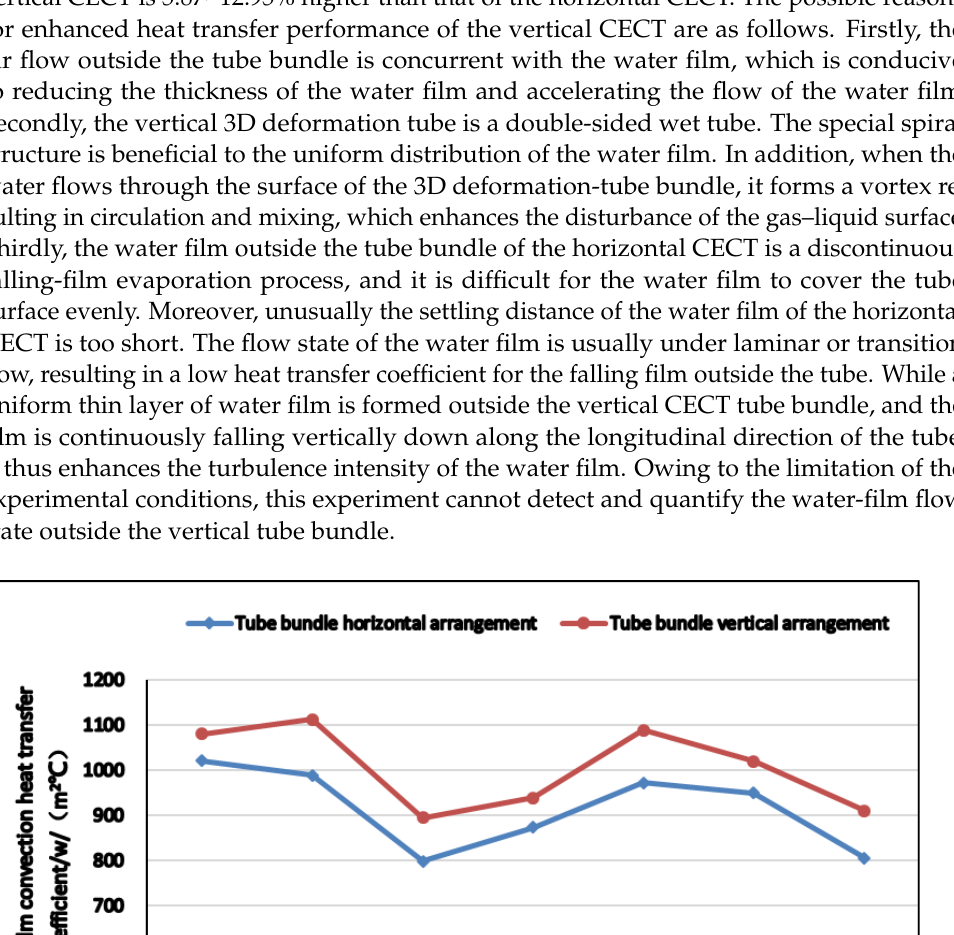
Figure 8. Variation trend of heat flux for the vertical CECT with ambient wet bulb temperature.